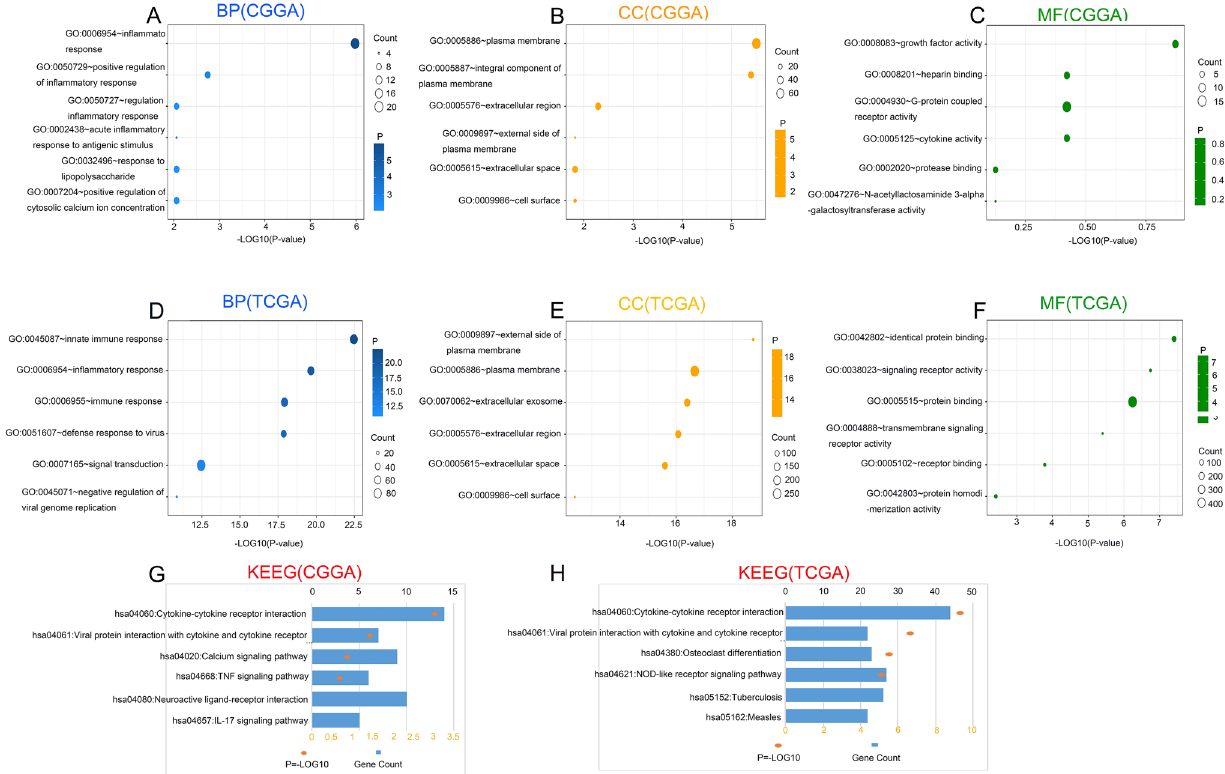
Fig. 8 CEACAM1 is closely associated with inflammatory response regulation in gliomas. A – C Biological processes (BP), cellular components (CC), and molecular functions (MF) are mostly related to CEACAM1 in the Chinese Glioma Genome Atlas (CGGA) database. D – F Biological processes (BP), cellular components (CC), and molecular functions (MF) are mostly related to CEACAM1 in the TCGA database. G Kyoto Ency- clopedia of Genes and Genomes (KEGG) pathway analysis of CCEACAM1 in the CGGA database. H KEGG pathway analysis of CEACAM1 in the TCGA